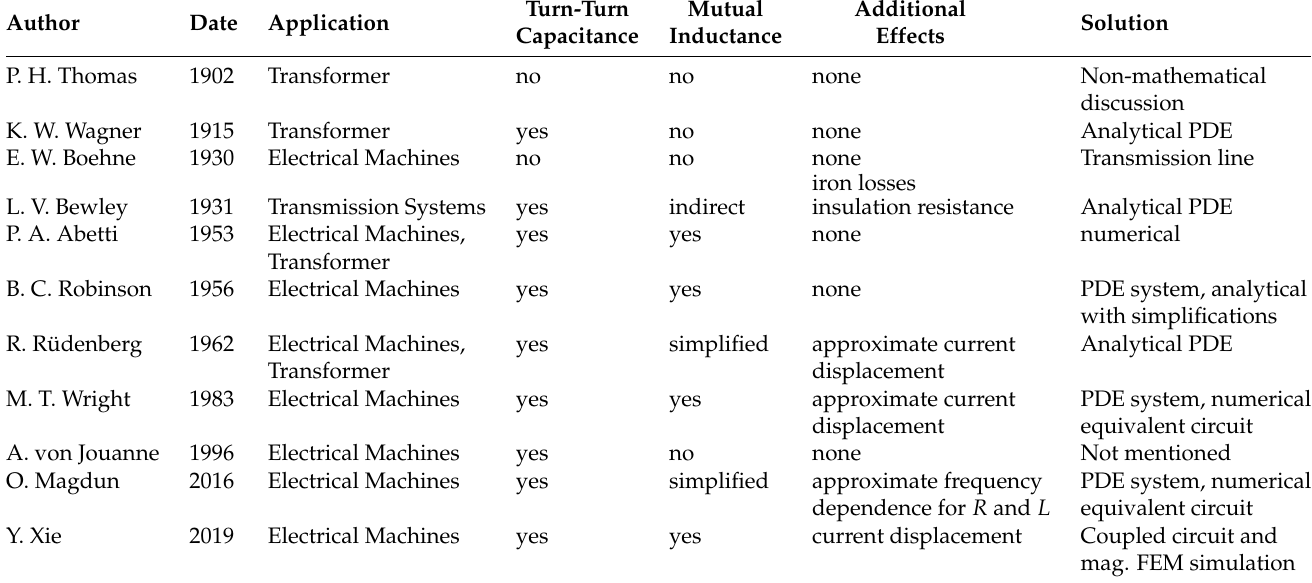
Table 1. Comprehensive comparison of the models and the effects which are taken into account, all models include the winding-stator